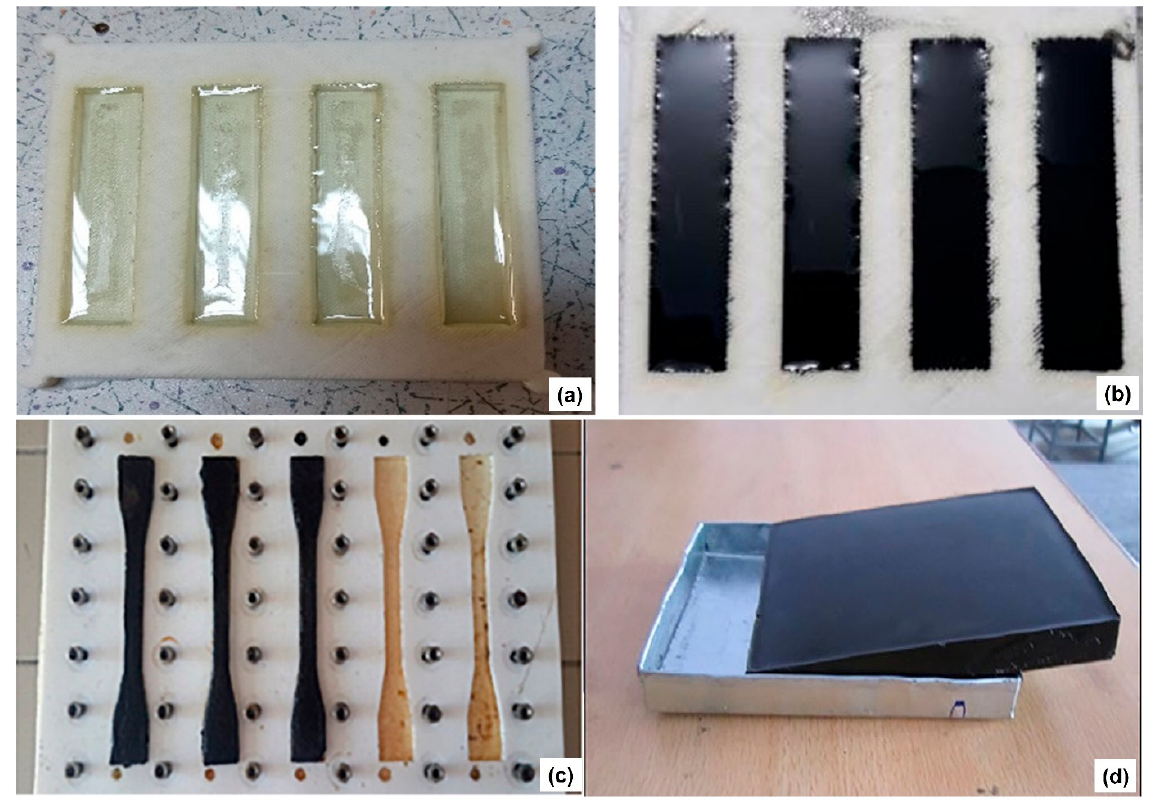
Figure 2. ( a , b ) Neat epoxy resin and epoxy composite made with a plastic-waste-derived char. Reprinted from Öner [53] and licensed under CC BY 4.0. ( c ) Epoxy composite made with polypropylene-waste-derived char. Reprinted from Sogancioglu et al. [41], Copyright (2019), with per- mission from Springer Nature. ( d ) Epoxy composite made with a tire-waste-derived char. Reprinted from Verma et al. [42], Copyright (2019), with permission from